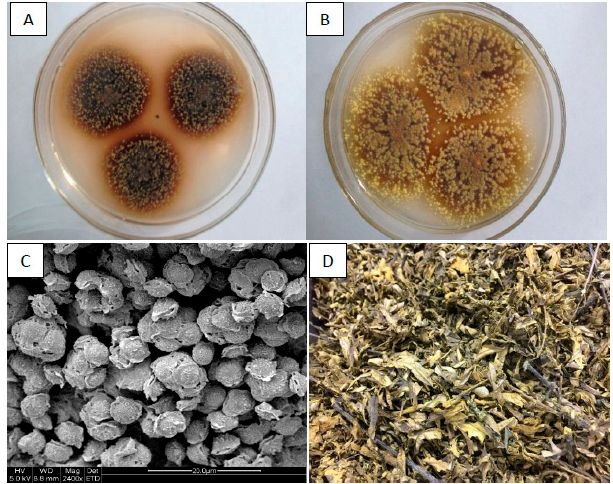
Figure 2. Morphological characteristics of Eurotium amstelodami BSX001 isolated from Fu brick tea. ( A ) Colonies grown on the CZA agar at 28 °C for ten days. (B) Colonies grown on the CZA20 agar at 28 °C for ten days. ( C ) SEM image of gold-sputtered samples of ascospores (incubated for two weeks), scale bar = 20 µm. ( D ) Hippophae rhamnoides leaves (HRL) with “golden flowers” visible to the naked eye.